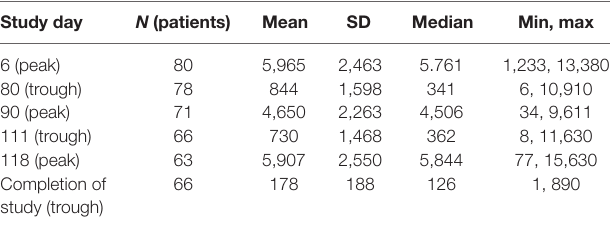
TaBlE 6 | Summary of dilution corrected mean of ch14.18 concentration values (ng/mL). Study day N (patients)